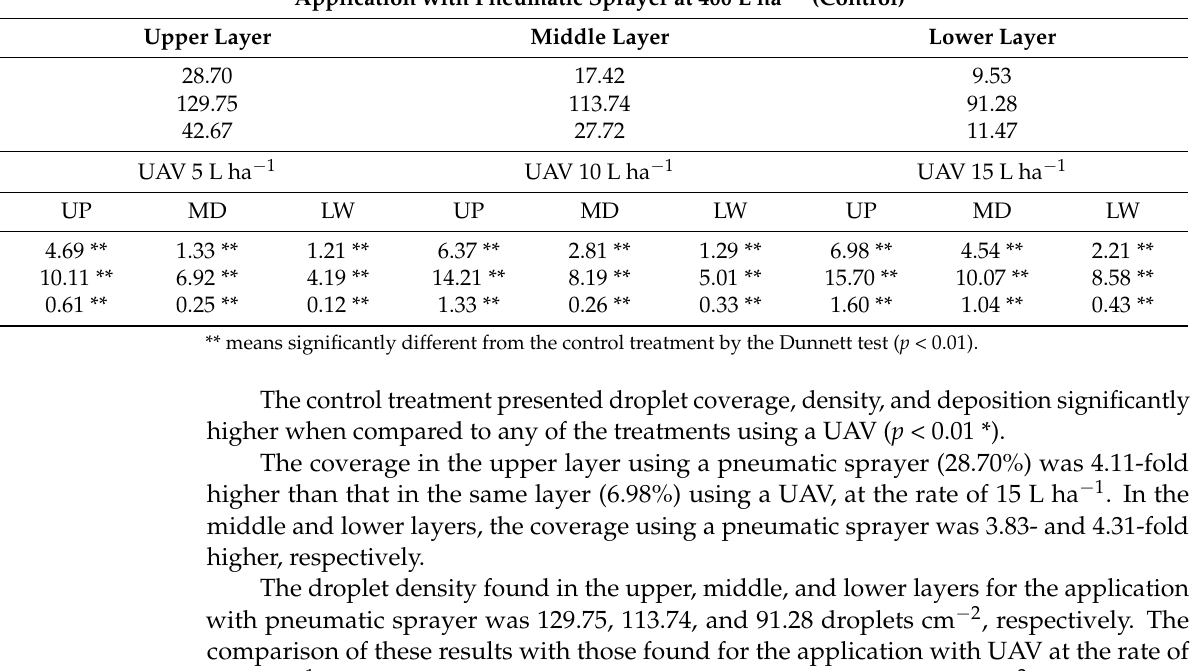
Table 6. Mean droplet coverage (CO, %), density (DN, droplets cm − 2 ), and deposition (DP, µ L cm − 2 ) in the upper (UP), middle (MD), and lower (LW) layers of coffee plant canopies by treatments using a UAV, compared to the control